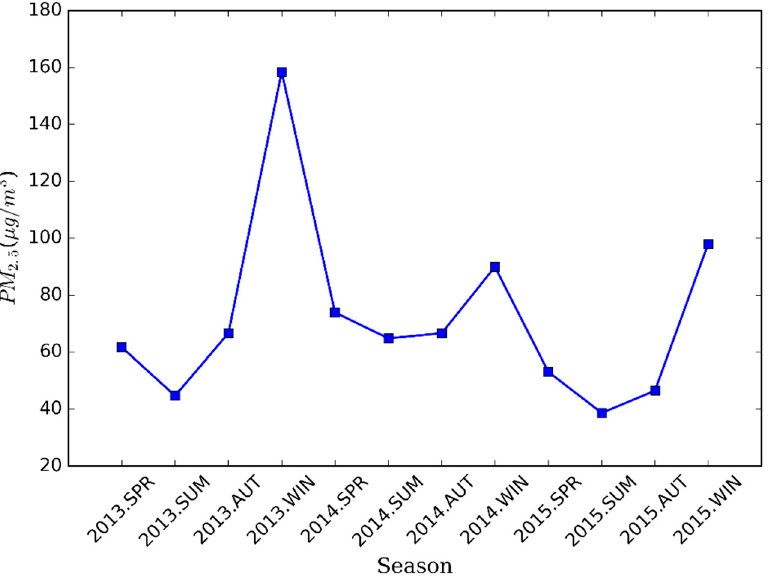
Figure 8. Seasonal distribution of PM 2.5 concentrations for three years based on the CEEMDAN decomposition results.